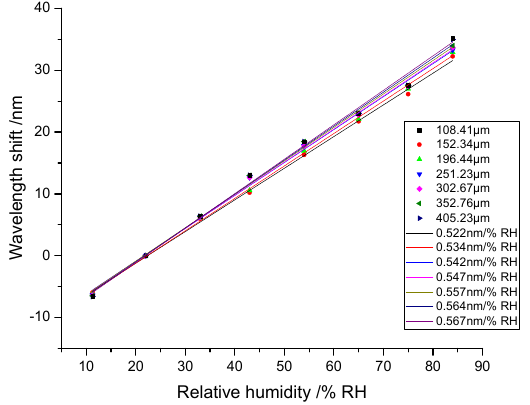
Figure 7. The relative humidity response curves of different Fabry-Perot cavity lengths.